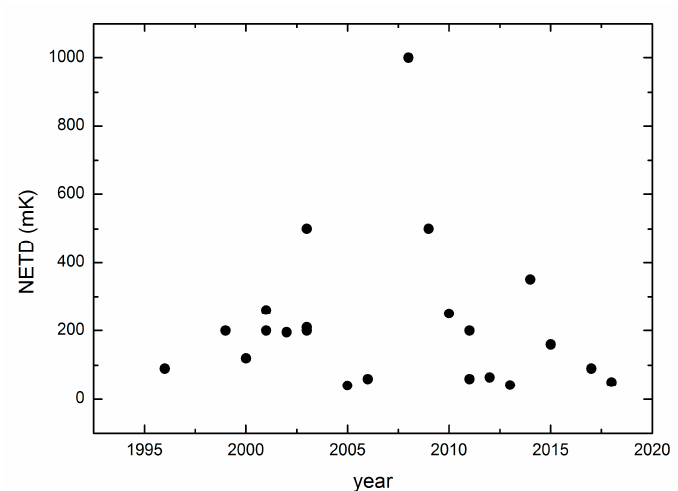
Figure 2. Trends of the noise equivalent temperature difference (NETD) for CMOS-compatible microbolometer IR detectors, data taken from (in left-to-right order) [12–15,17–22,25–29,31,33– 35,37,40,46].